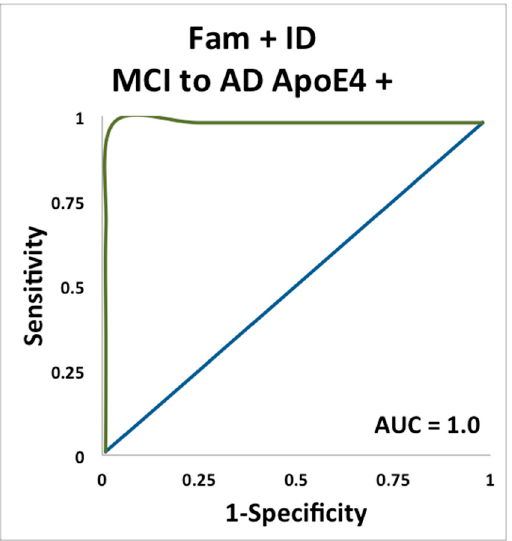
Figure 5. ROC curve plotting sensitivity and specificity for predicting conversion from MCI to AD